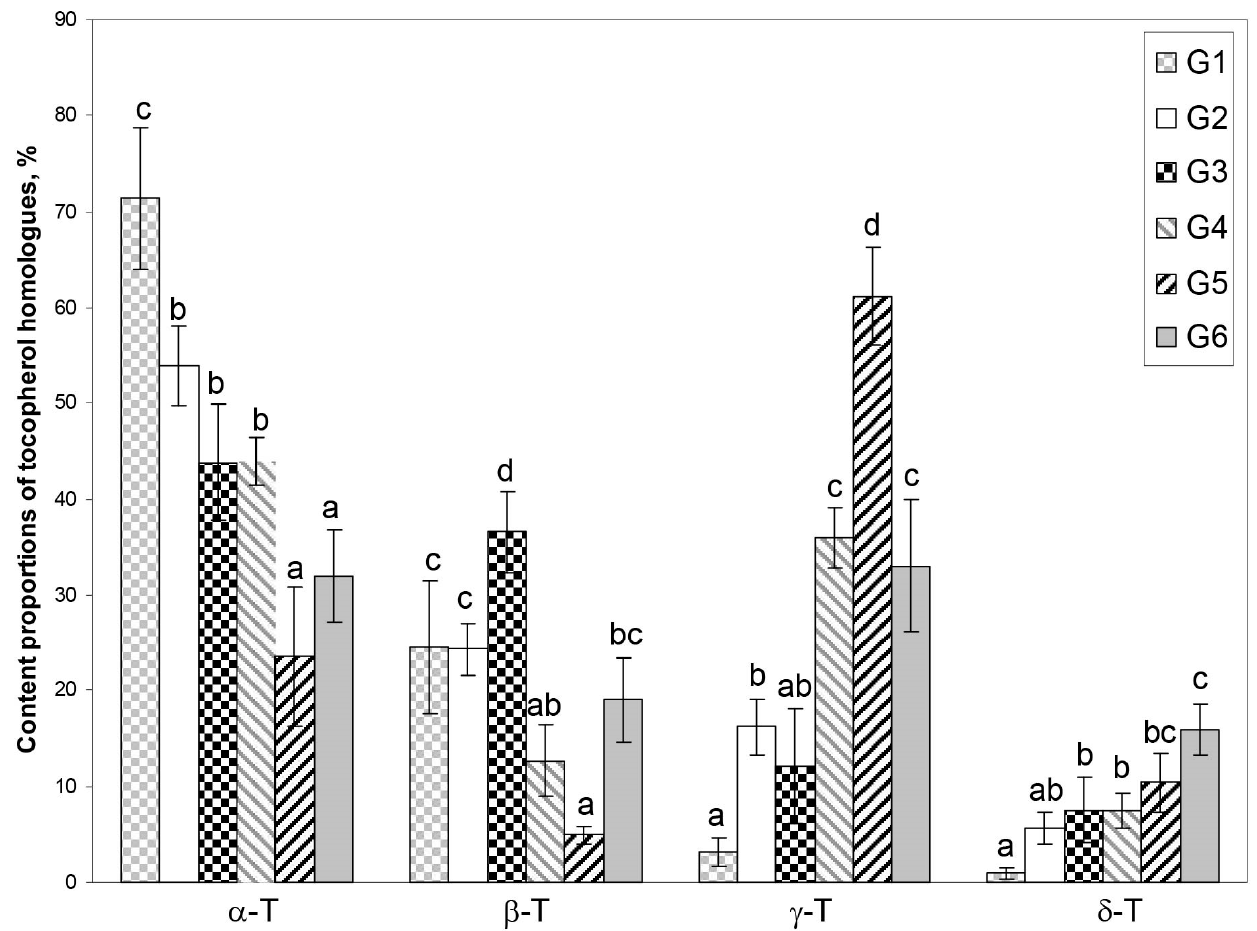
Figure 4. The content proportions of tocopherol homologues ( α , β , γ , and δ ) (%) in groups (G1–G6) assigned by the PCA. Statistically significant differences among groups were assigned by ANOVA and unequal n Tukey test ( p < 0.05).